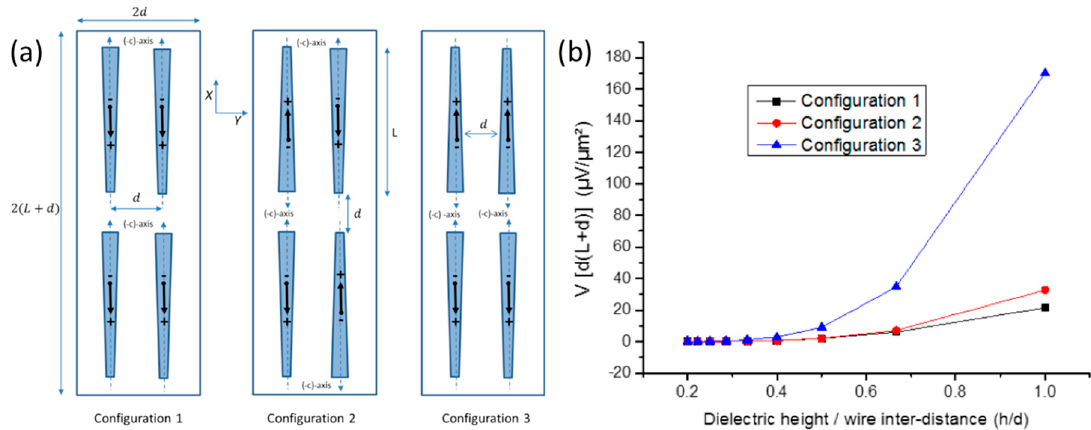
Figure 13. ( a ) Schematics of three in-plane arrays of two-dimensional wire assemblies. The black arrows sketch the equivalent electric dipoles shown in Figures 7 and 11. ( b ) Comparison of the evolution of the normalized potential by unit surface as function of h/d for configurations shown in ( a ). The value of h is fixed at 2 µm while d is varied between 2 and 10 µm.